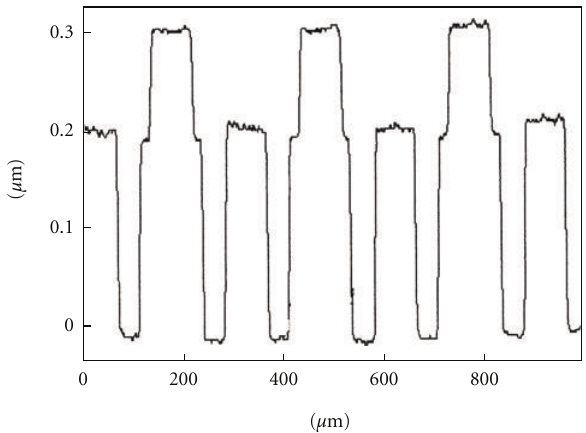
Figure 2: Depth profile of an interdigitated electrode